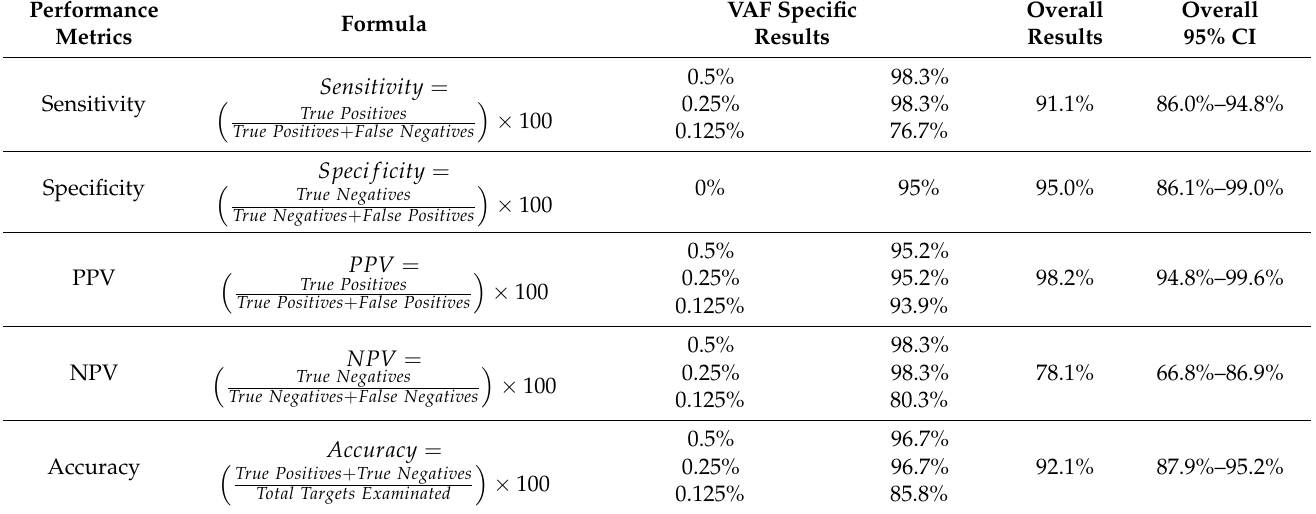
Table 1. Summarized performance metrics of the DEEPGEN TM assay. The sensitivity, specificity, PPV, NPV and accuracy of the variant calling was calculated for the verified VAF of 0%, 0.125%, 0.25% and 0.5%. The overall result (across validated VAFs) and the 95% confidence intervals (CI) are